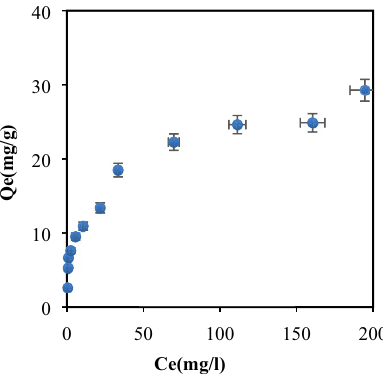
Figure 9. Isothermal adsorption of CB on bean peel (BP) (m (Bb) = 3.6 g/L; C i = 10–300 ppm; pH = 2.2; ω = 250 tr/ mn; T = 25 °C; t = 4 h).